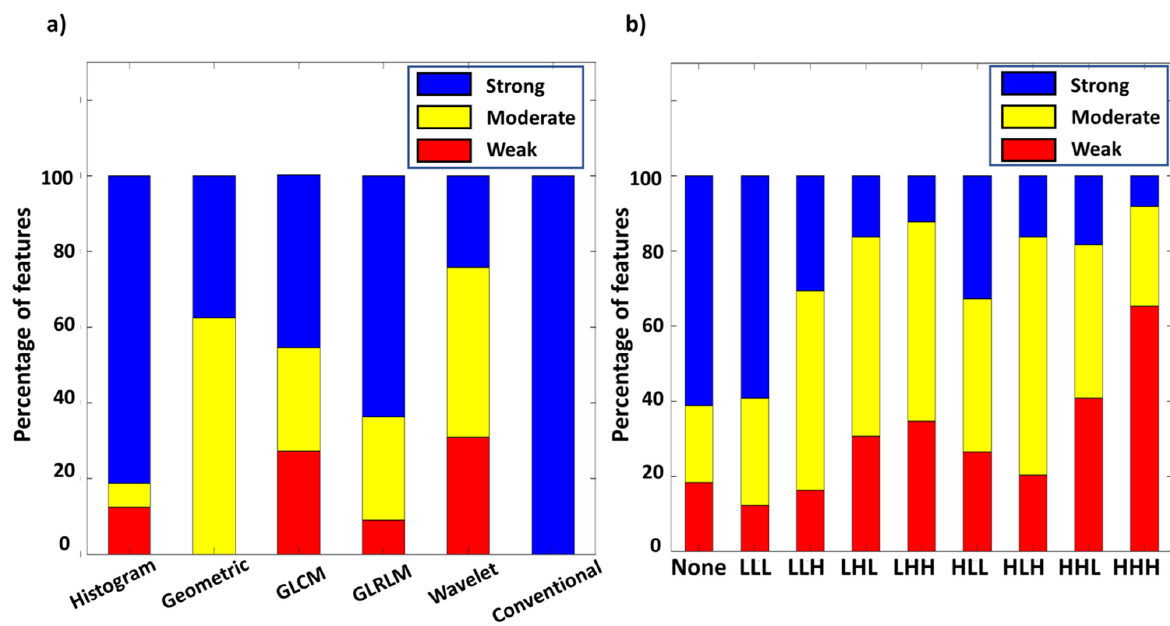
Figure 4. Percentage of different level of comparability among radiomic types ( a ), and wavelet types ( b ).